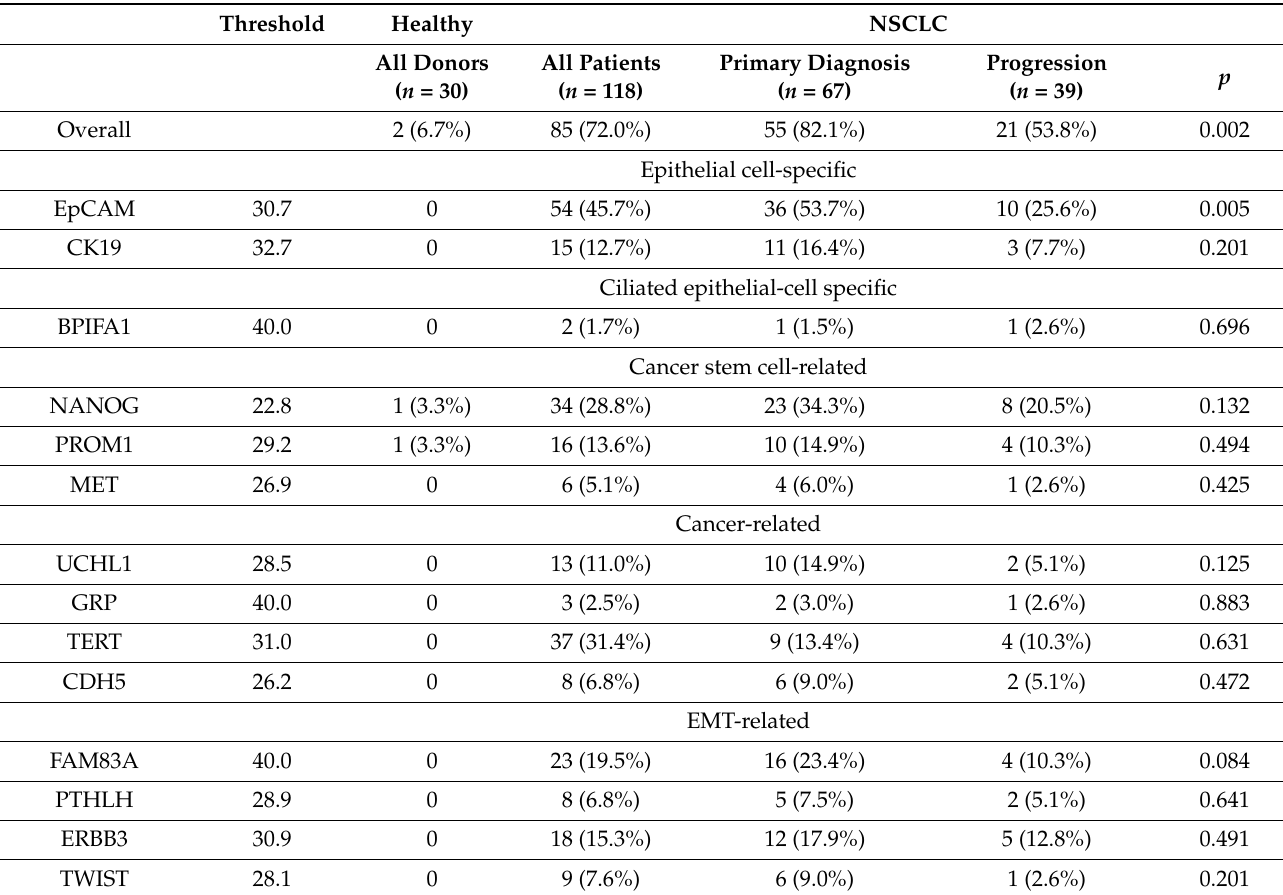
Table 2. Prevalence of gene expression levels beyond the diagnostic threshold in 30 healthy donor blood samples and 118 NSCLC patients. The absolute and relative numbers of positive findings is given for the total study population and stratified by the stage of disease at blood draw (primary diagnosis and progression). The chi 2 -test was performed to examine the relation between marker positivity and stage of disease at time of blood draw (primary diagnosis vs. progressive